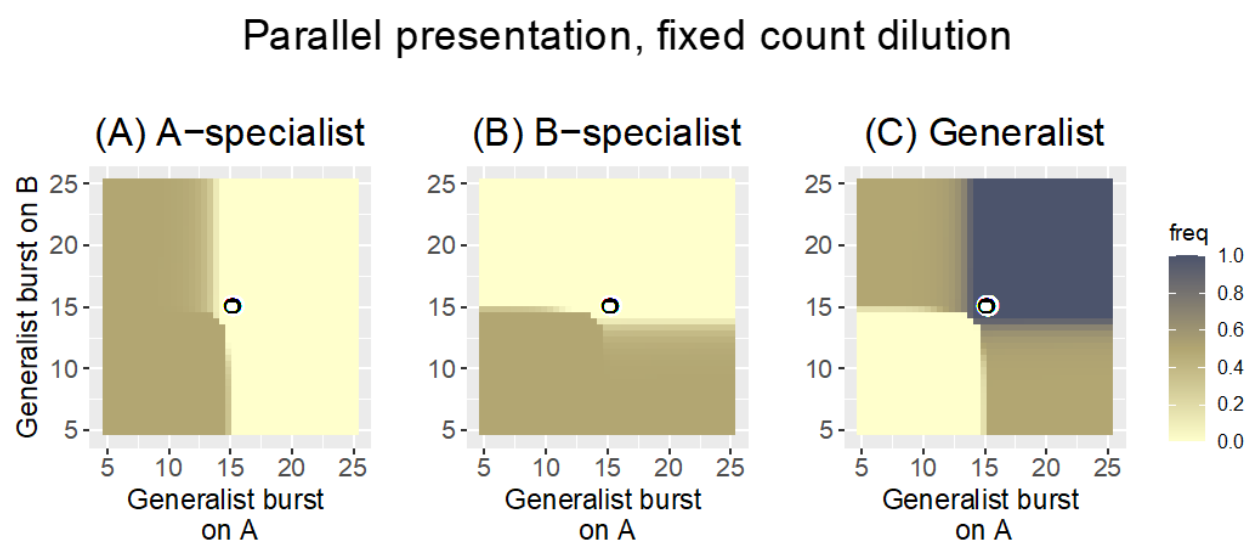
Figure 2. Heat maps of Parallel presentation with equal burst sizes of the two specialists ( b A|A = 15, b B|B = 15, as indicated by the coordinates of the black-on-white ring). The three panels show the frequency of the A-specialist ( A ), the B-specialist ( B ), and the generalist ( C ), respectively, across a range of generalist burst sizes. As given in the key, phage frequency at 1000 time steps is indicated by color, with darker colors representing higher frequencies. The generalist is lost if both its burst sizes are less than those of the specialists. Each specialist is lost when its burst size falls below that of the generalist on that host. There are substantial zones in which two phages are maintained (either the two specialists are maintained or a specialist and the generalist are maintained), although only the generalist is maintained in the upper right quadrant. Because phages with the highest burst sizes on each host are maintained, Parallel presentation is a ‘fair’ arbiter of phage growth. There is a slight advantage to being a generalist in that the generalist displaces the specialist even when the generalist bursts are both slightly less than that of the respective specialist. Bacterial growth rate is r = 0.3 and the fixed-count dilution reduced phage density to 1000 every 20 time steps. Phage frequencies were calculated as a phage’s density relative to the combined density of all phages.